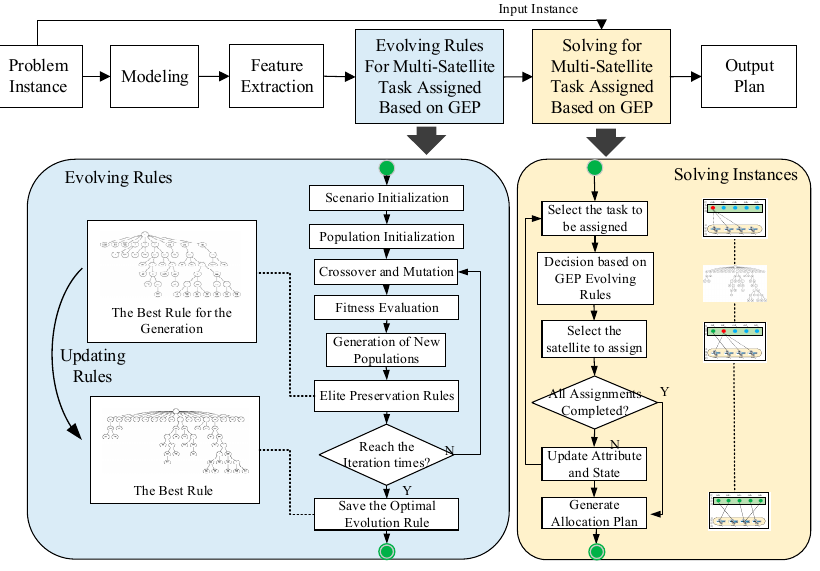
Figure 3. The CHMGEP Algorithm framework.